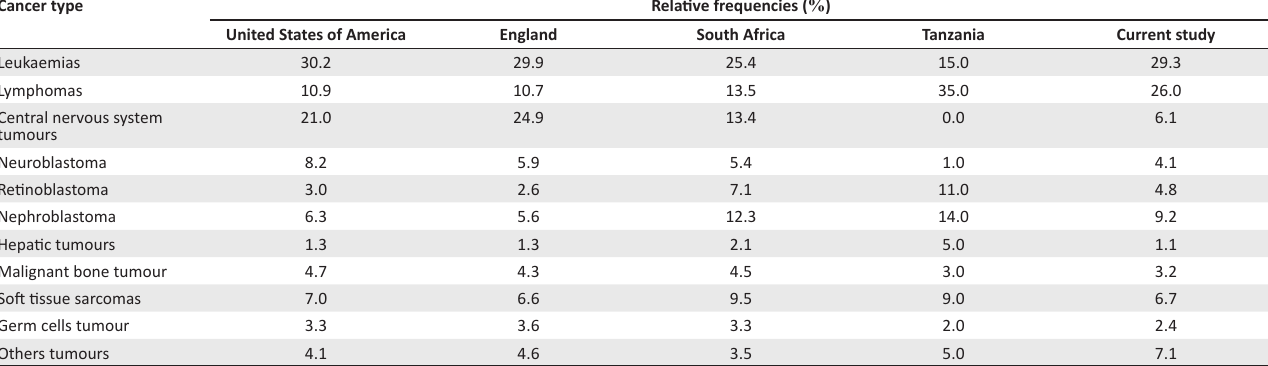
TABLE 4: Comparative relative frequencies data from other low- and middle-income countries countries 10,34 and high-income countries. 30,31 Cancer